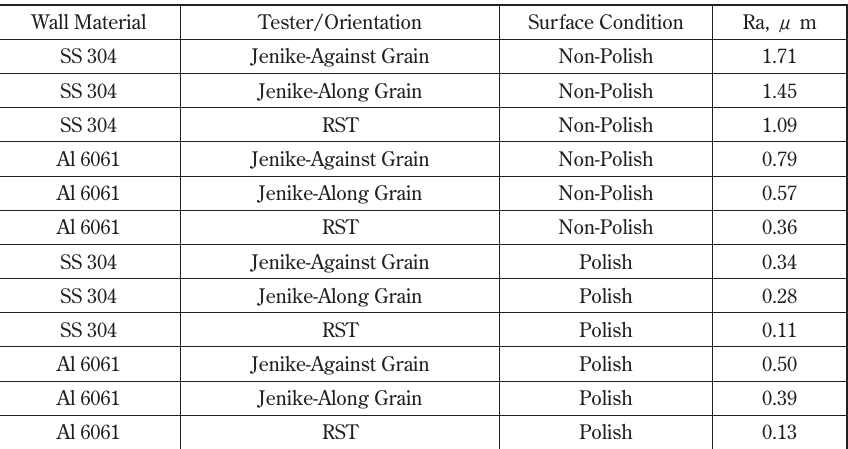
Table 2 Wall roughness of wall